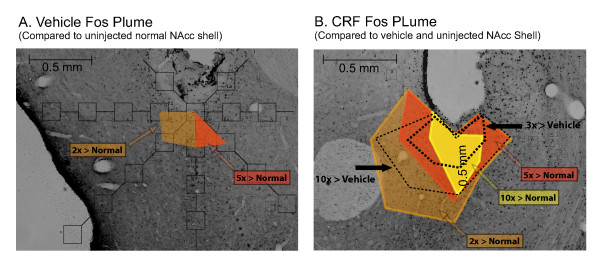
Fos plumes. Coronal sections showing point sample positions used to identify local Fos plumes around microinjection site. A. Vehicle microinjection produces merely low elevation of Fos compared to normal virgin tissue. Radial arms extending from center show sampling points for Fos measurement (125 μm × 125 μm blocks; 5× magnification). B. CRF microinjection induces intense elevation over normal tissue levels (depicted by color: 10× elevation over normal denoted by yellow, 5× = dark orange; 2× = light orange). CRF also causes elevation compared to vehicle microinjection levels at equivalent points (depicted by dotted lines; 3× relative increase over vehicle-levels denoted by thick dotted line, 5× = thin dotted line; upper right; plume from CRF 500 ng dose in 0.2 μl microinjection volume).